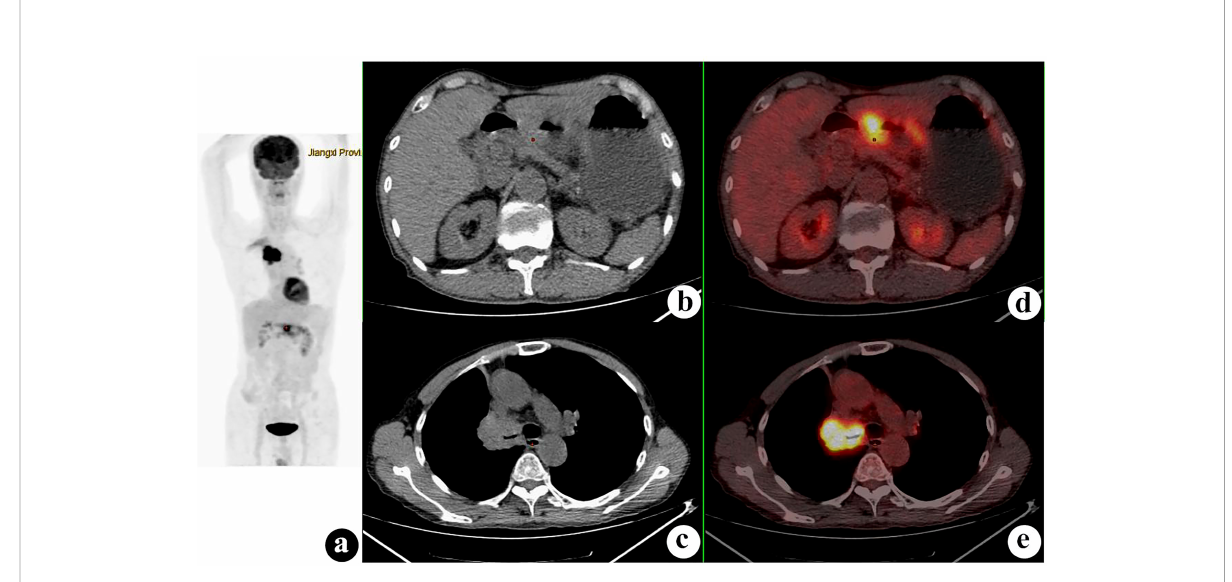
FIGURE 5 18 F- fl uorodeoxyglucose positron emission tomography/computed tomography ( 18 F-FDG PET/CT) of a 60-year-old man with gastric adenocarcinoma (GA) and synchronous right lung squamous cell carcinoma. GA was proven before PET/CT, and PET/CT demonstrated a 47 × 40-mm right hilar mass with a maximum standardized uptake value (SUV max ) of 13.9. (A) PET maximum intensity projection (MIP). (B, C) Axial CT. (D, E) Fusion images.